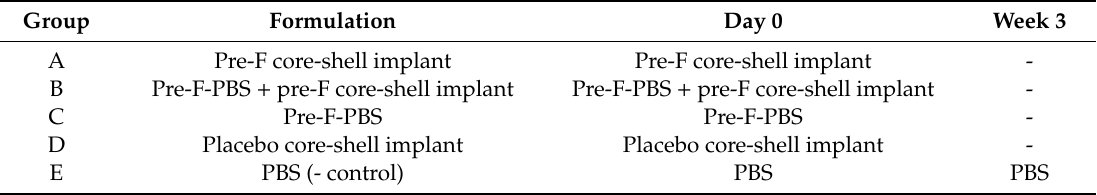
Table 1. Overview of the groups and formulations used for the in vivo